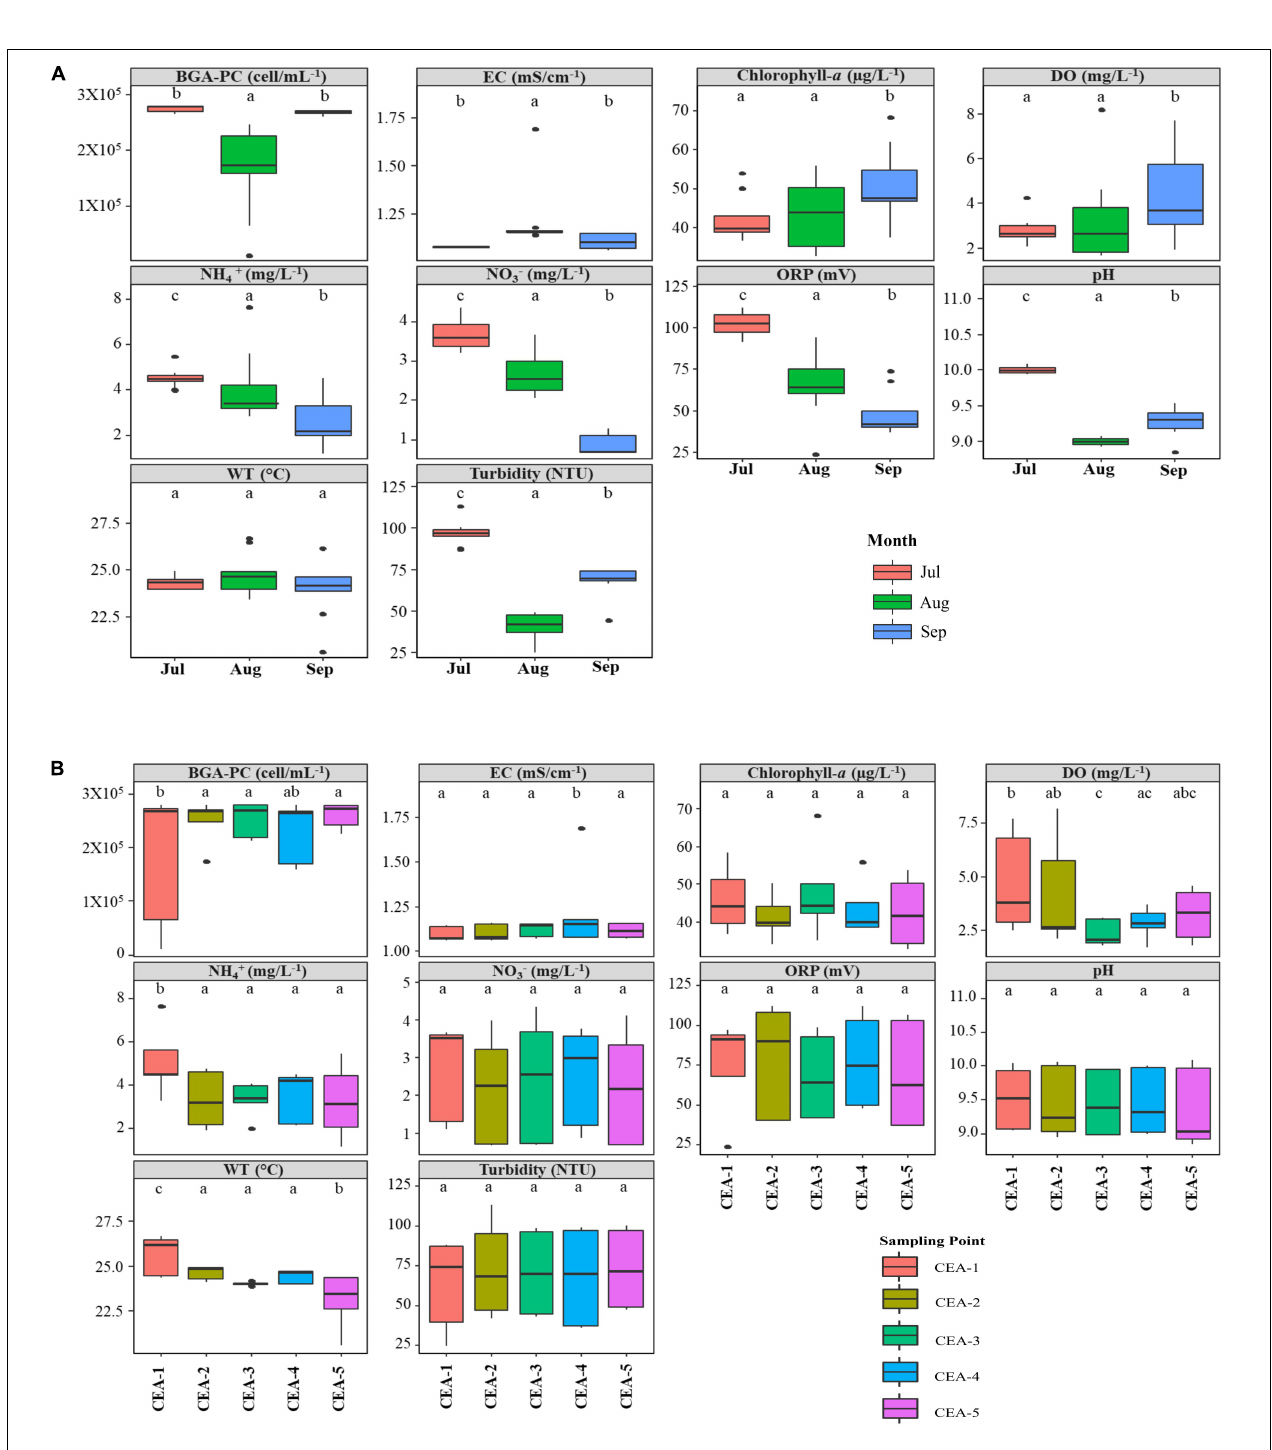
FIGURE 3 | Physicochemical and environmental parameters by month and sampling site. (A) Box plots of physicochemical parameters by sampling month. (B) Box plots of physicochemical parameters by sampling point.